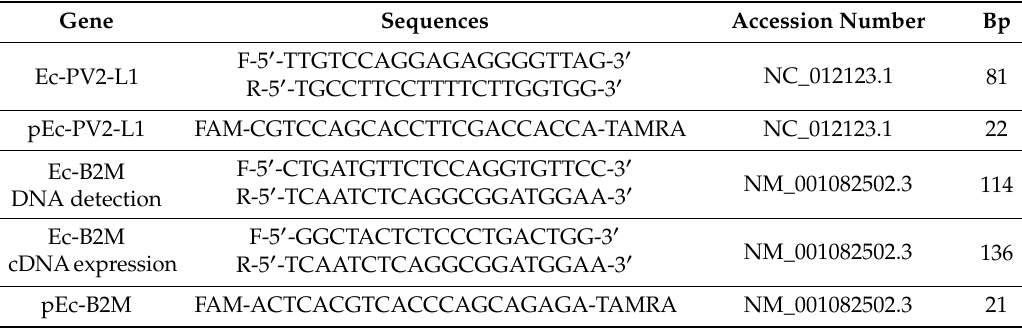
Table 2. Primers Set and probes used to evaluate EcPV2 presence and expression.